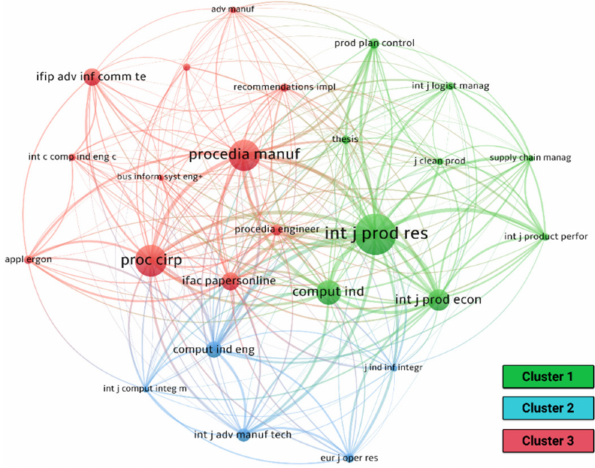
Figure 4. Co-citation analysis network of smart logistics in Industry